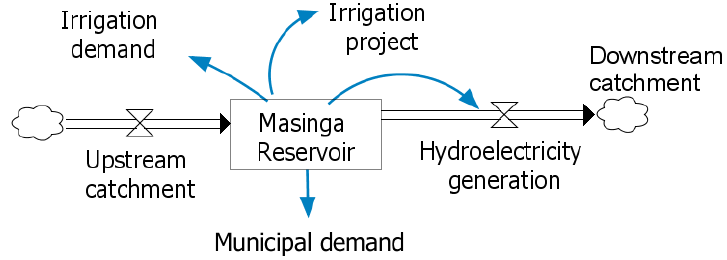
Figure 4. Masinga dam system.